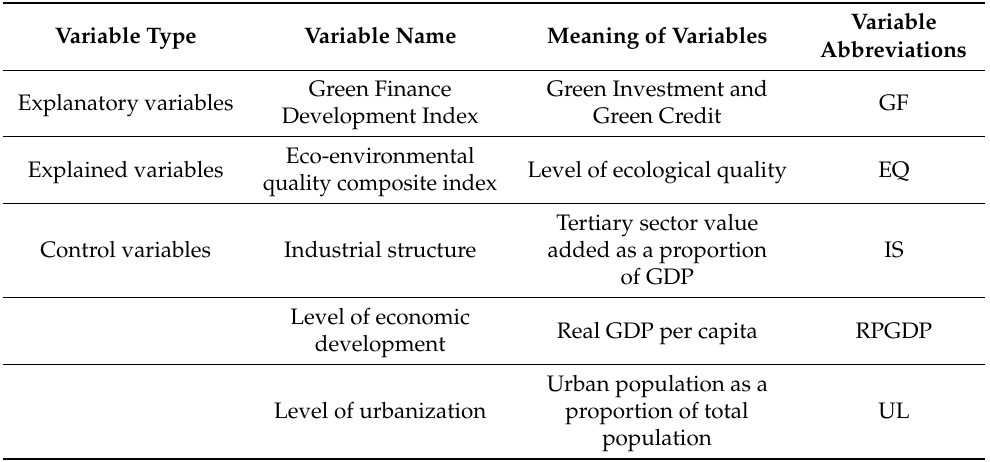
Table 6. Summary and description of